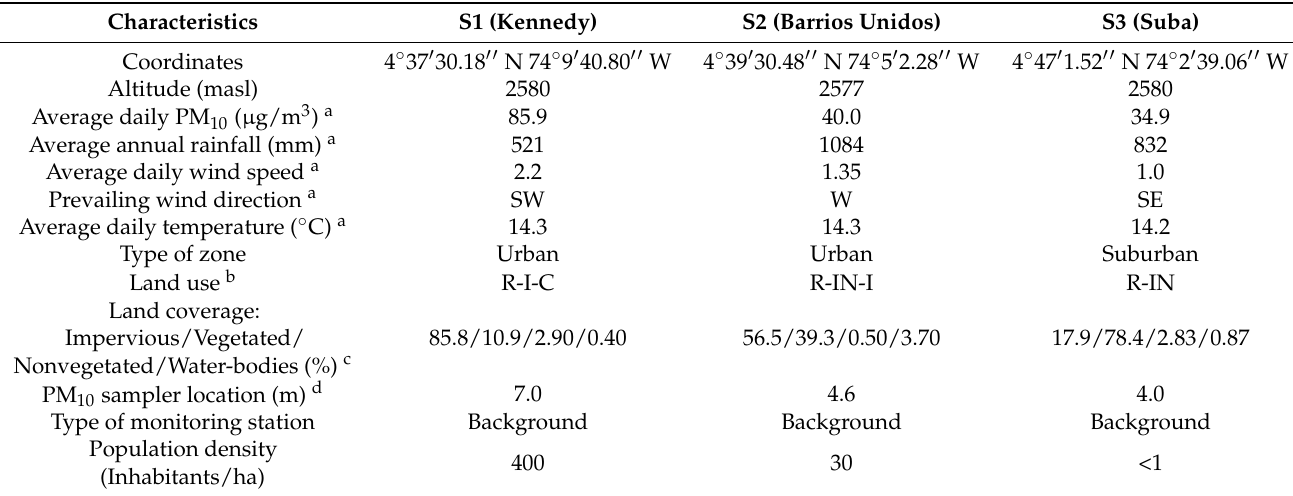
Table 1. Physical characteristics of study